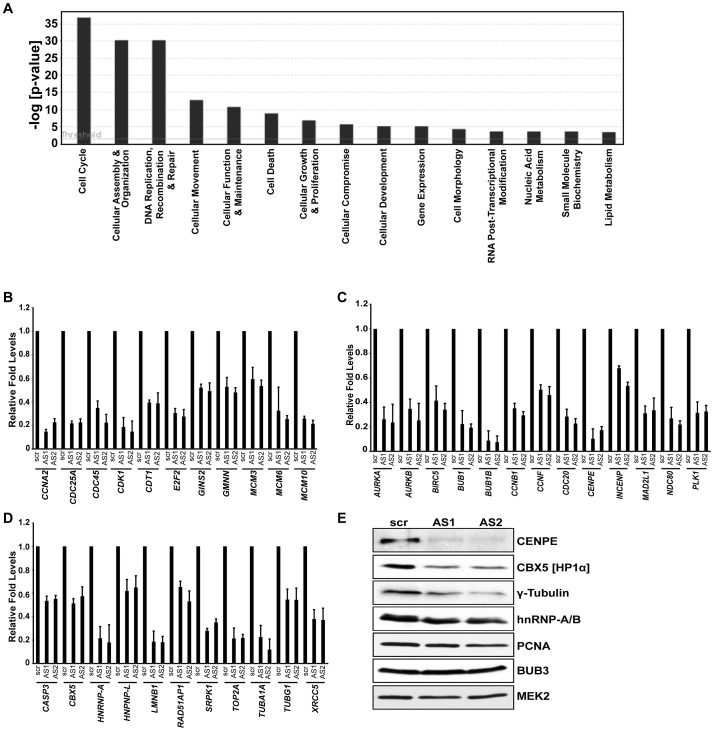
Microarray analysis in HDFs reveal that MALAT1-depletion reduces the expression of genes involved in cell cycle progression.(A) Top significant biological processes for genes whose transcript levels are reduced (Z ratio ≥2.5) in MALAT1-depleted fibroblasts. Cell cycle is the most affected biofunction in MALAT1-depleted cells. (B–D) qRT-PCR analyses in control (scr) versus MALAT1-antisense (AS1 & AS2) oligo-treated HDFs reveal decreased mRNA levels of genes involved in G1/S transition (B), mitotic progression (C), and other general cellular processes (D) upon MALAT1 depletion. (E) The expression of indicated genes is determined by immunoblotting using extracts from control and MALAT1-depleted WI-38 cells. MEK2 is used as loading control.